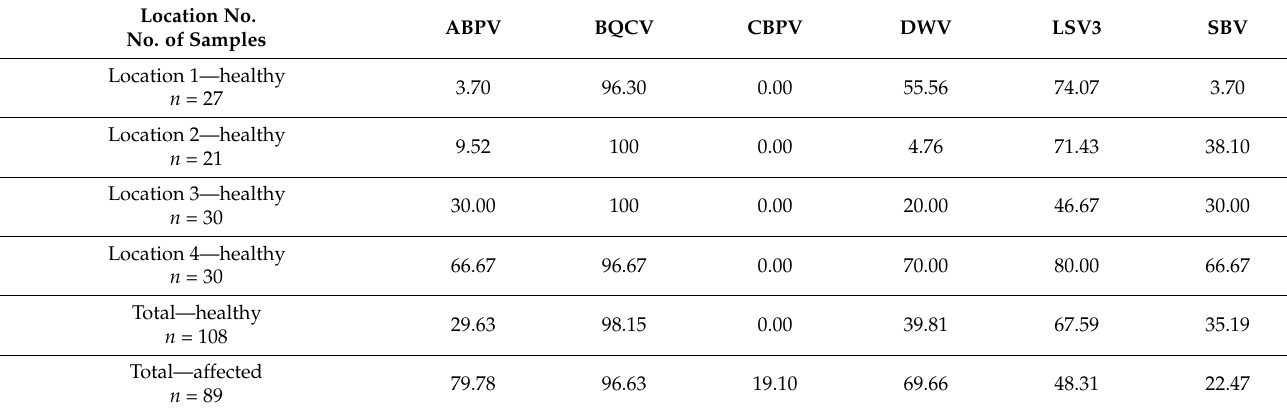
Table 4. The obtained prevalence for ABPV, BQCV, CBPV, DWV, LSV3, and SBV in healthy and clinically affected honeybee colonies detected by RT-qPCR